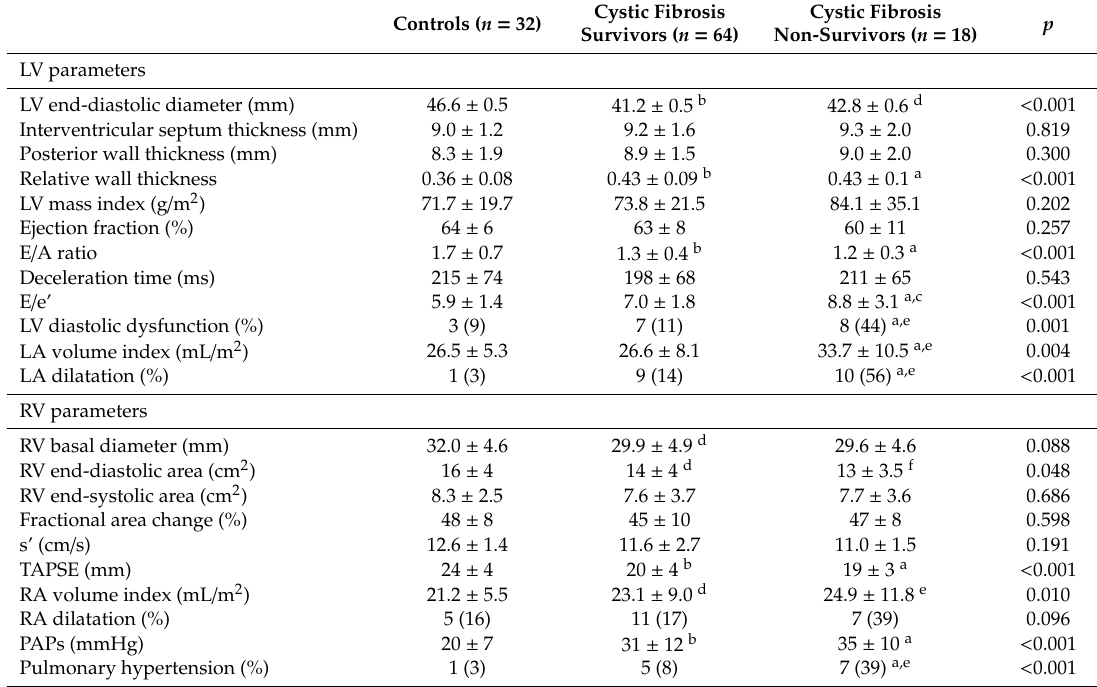
Table 2. Echocardiographic parameters of the study